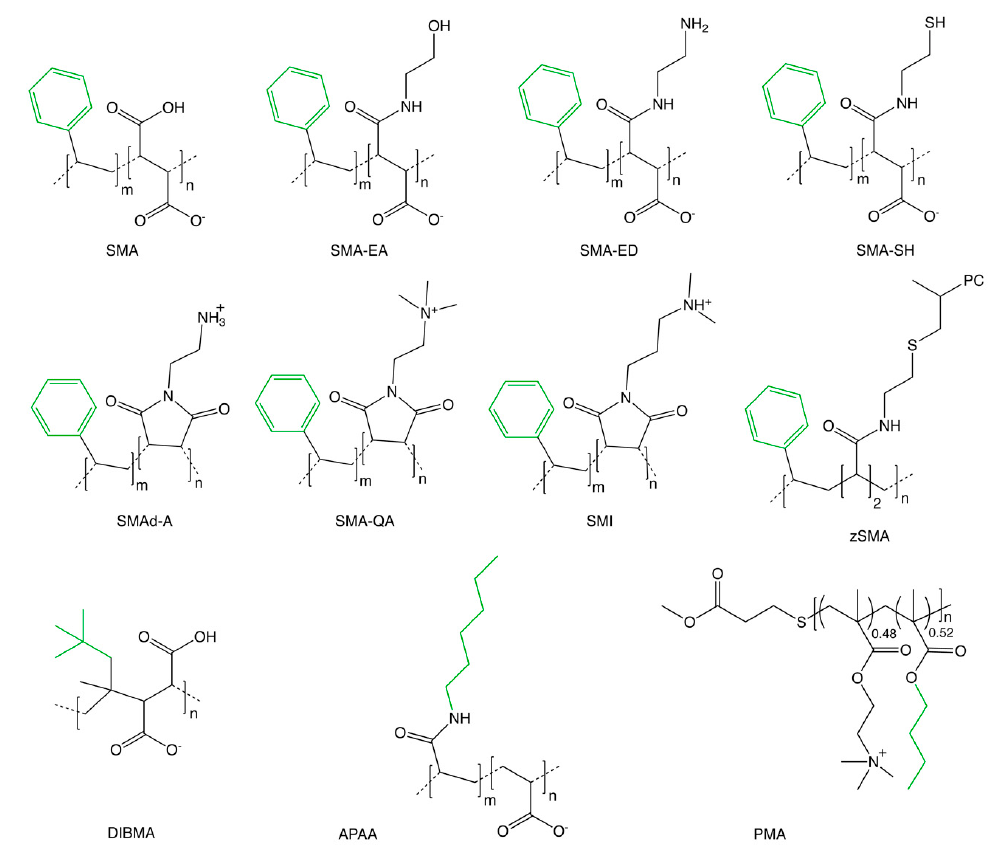
Figure 2. Family of SMA copolymers used to solubilize memteins. The chemical structures of copolymers developed for solubilizing membrane:protein complexes from biological membranes into native nanodiscs include: SMA [20], SMA-EA [34], SMA-ED, SMAd-A [36], SMA-QA [37], SMI [38], SMA-SH [43], zSMA [39], DIBMA [40], APAA [42], and PMA [41]. The non-polar sidechains are colored green.